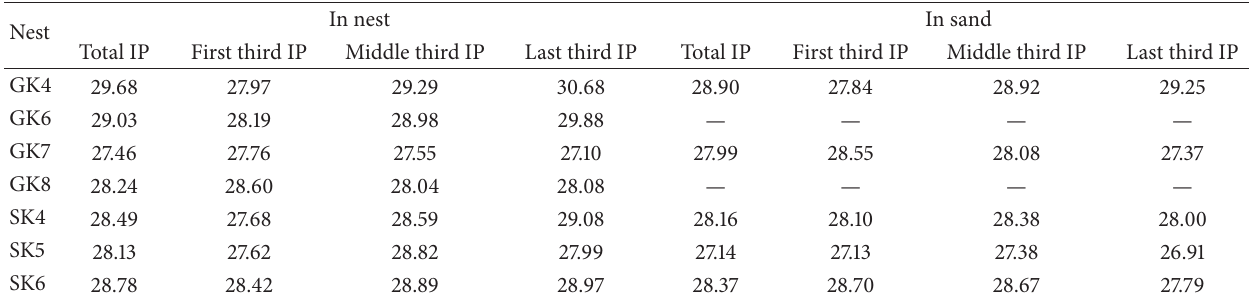
Table 2: Mean temperature in study nests and adjacent sand during different incubation periods. IP, incubation period. The data loggers in sand adjacent to nests 6 and 8 in Great Kuriat were